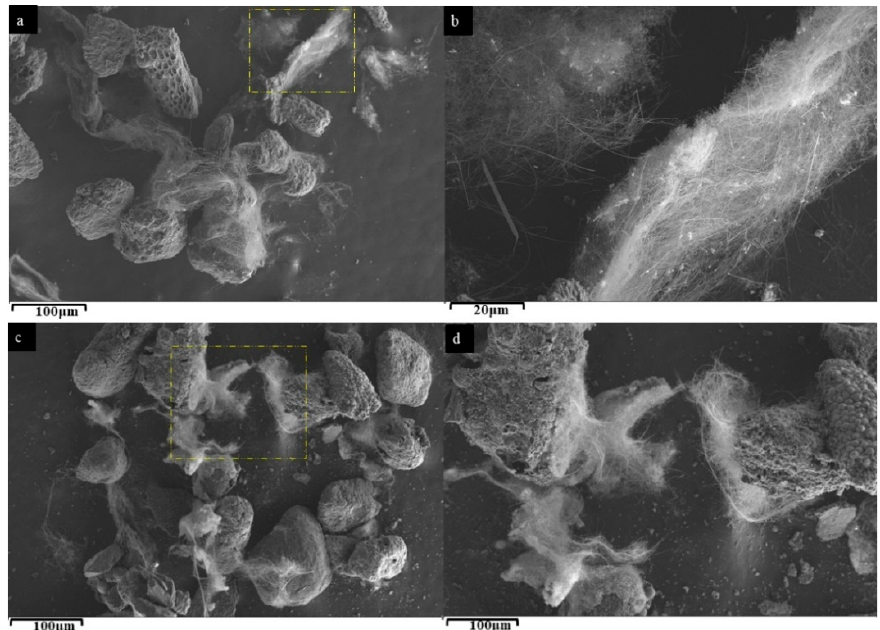
Figure 3. SEM images of ( a ) SL-CNTs used for length measurements, ( b ) magnified image of mapped out section in ( a ), ( c ) SL-CNTs on different particles, ( d ) magnified image of mapped out section in ( c ). Table 2. Length measurements of SL-CNTs from ImageJ analysis.